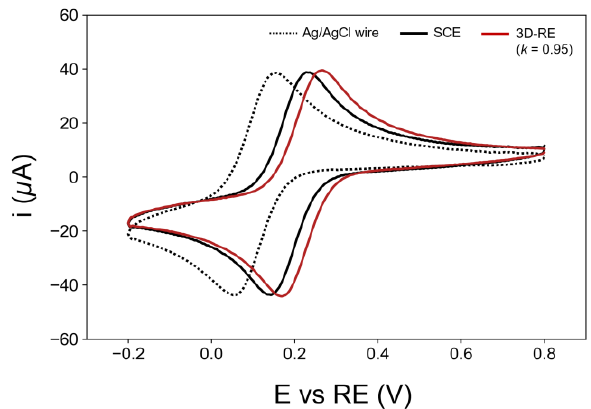
Figure 9. Cyclic voltammograms of 4 mM ferricyanide in 0.1 M KCl recorded using a carbon paste working electrode, Pt wire counter electrode, and different reference electrodes (commercial SCE, 3D-RE ( k = 0.95), and Ag | AgCl pseudoreference electrode).